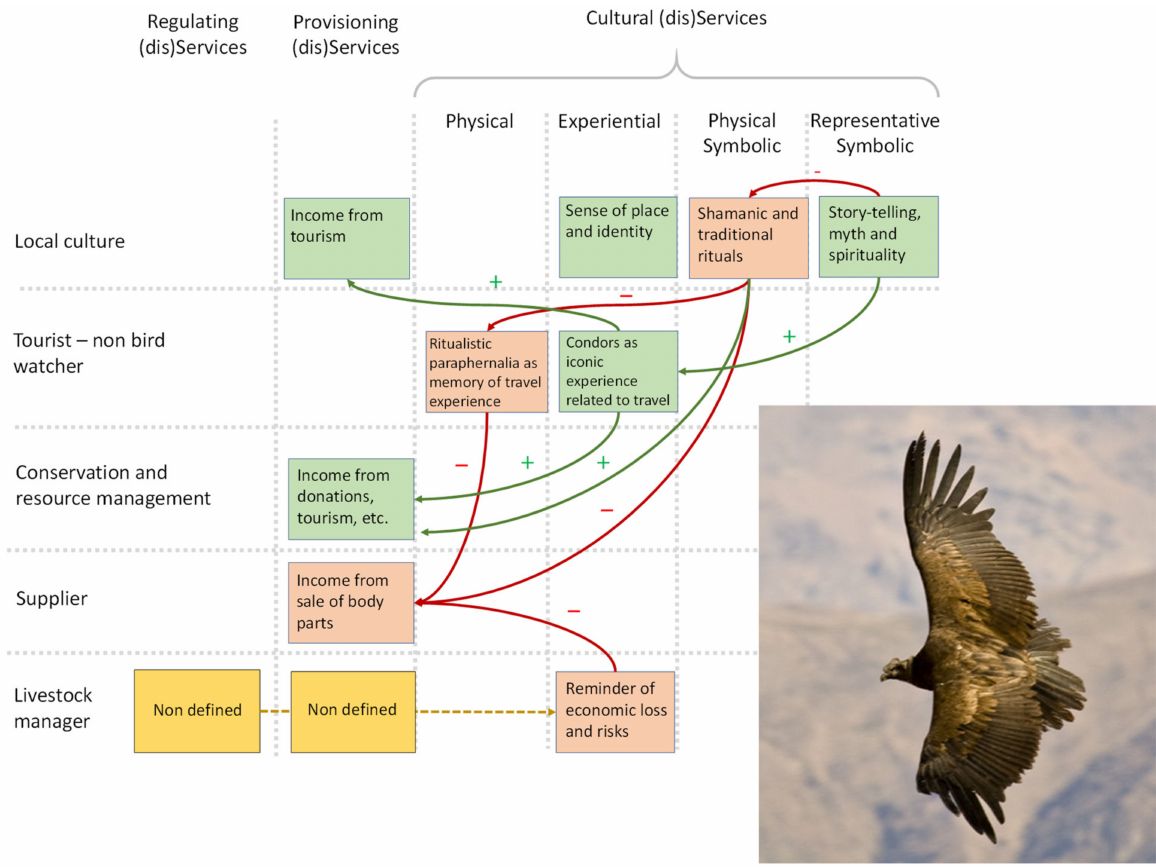
Figure 4. Possible connections between non-tangible cultural services and tangible provisioning and regulating services derived from the Andean Condor ( Vultur gryphus ). Green lines (+) and symbols indicate services with benefits for condor conservation, red lines ( − ) and orange symbols indicate services that counter conservation efforts and yellow symbols remain undefined (see text). Information related to the Andean Condor is taken from Williams et al. [55], Rend ó n and Bidwell [67], Sault [34], and Zuluaga et al. [122]. Andean Condor adapted image by szeke licensed under CC BY-NC-SA